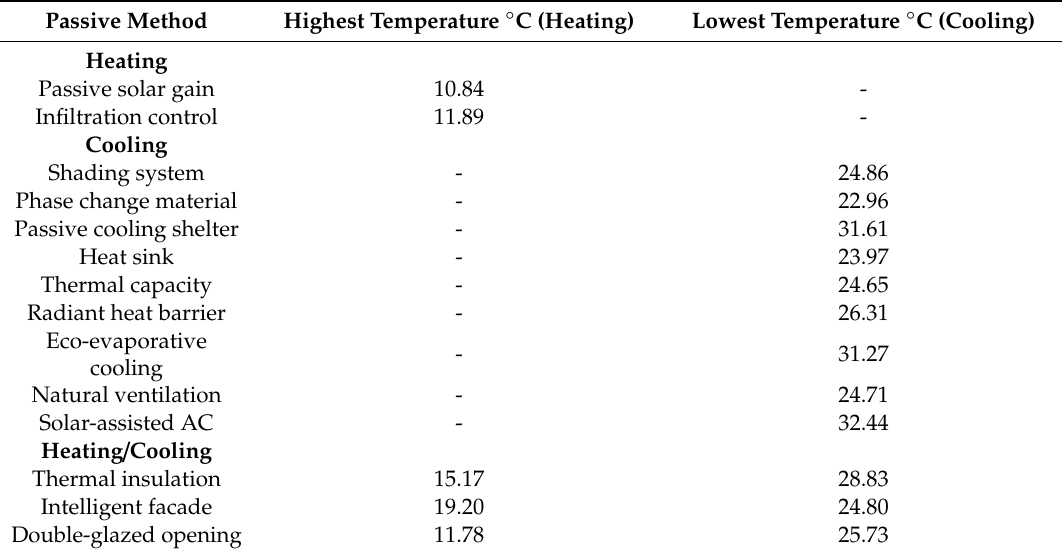
Table 6. Indoor temperature of passive cooling and heating methods without any occupants